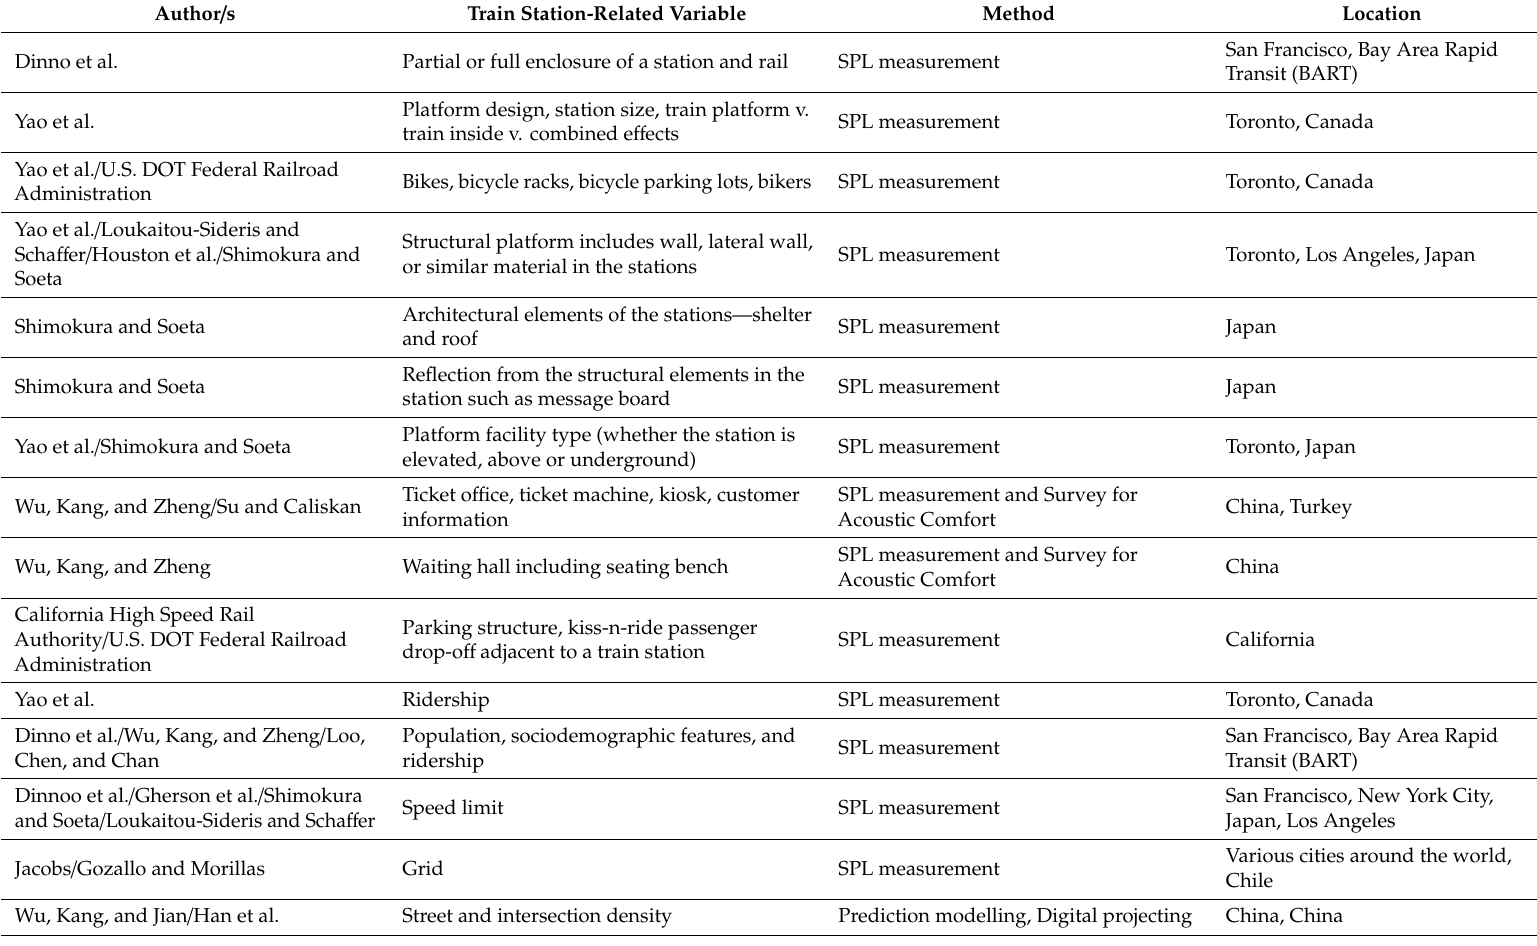
Table 2. Variable review summary on both train station and neighborhood